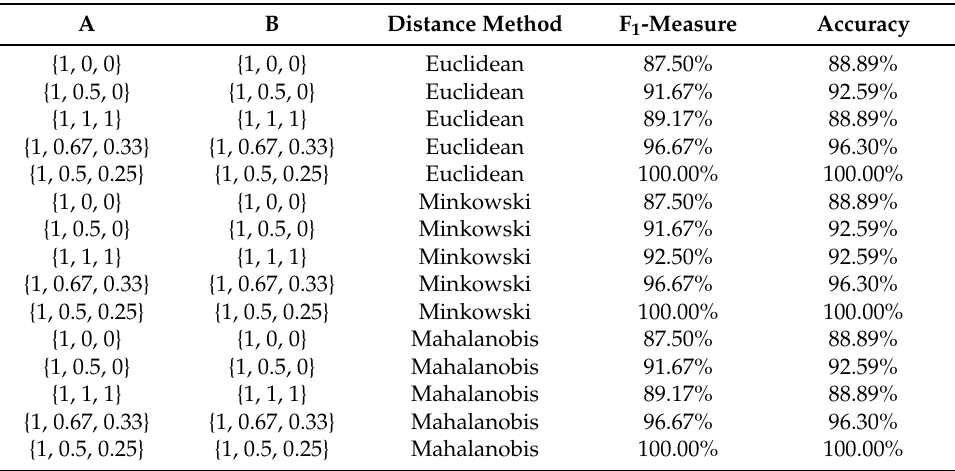
Table 5. The comparisons of different parameters for vehicle positioning.